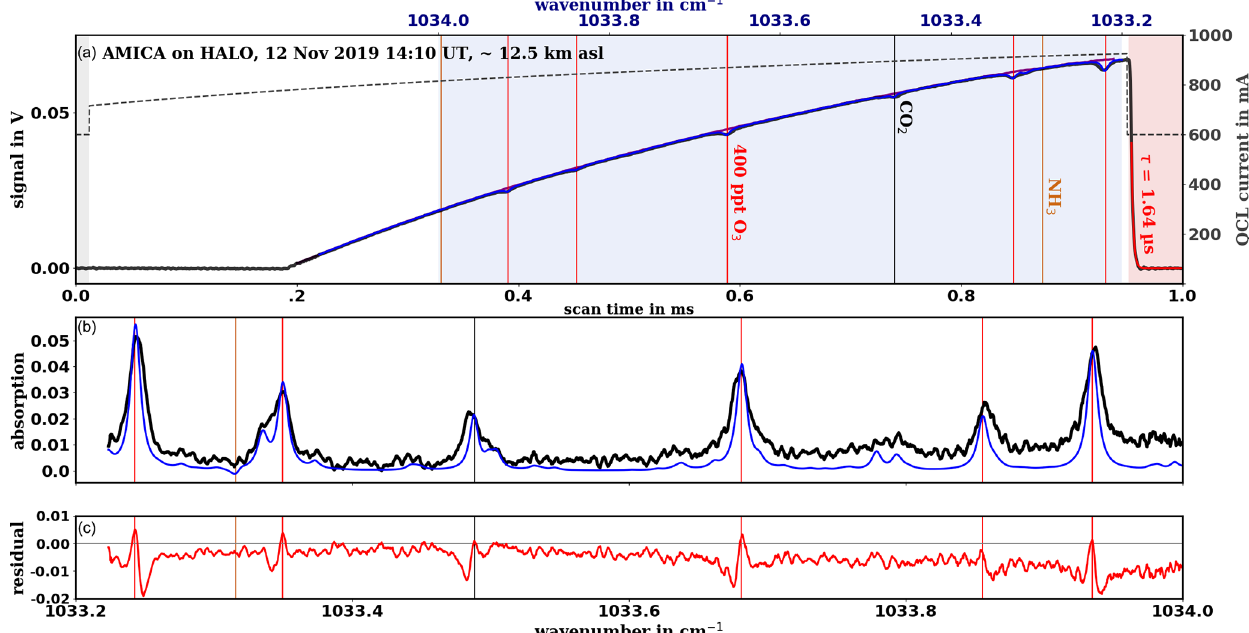
Figure 10. (a) QCL current (dashed line, right axis; the 775–925mA ramp is slightly curved to arrive at the linear wavenumber scale indicated on the top x axis) and detector voltage signal past the preamplifier (solid black line, left axis; ramps averaged over 30s) for AMICA cavity 2 in the 1034cm − 1 setup. Three periods are marked by the coloured areas – (i) grey: only detector dark signal (with zero offset) is observed; (ii) blue: period used for spectral analysis; (iii) red: period after the QCL stops emitting, when the signal decays exponentially due to ring down of the light in the cavity. A ring-down fit is shown by the red line. For the spectral fitting region, a measured baseline spectrum with no absorbers present (purple) and a fitted spectrum (blue) are also shown. (b) Measured and fitted spectra from (a) shown in absorption space. (c) Difference between the fit and the measured spectrum (fitted–measured). Panels (b, c) only show data for the region that is actually fitted, i.e. the blue shaded region in (a) . Absorption line positions coloured according to different gases are indicated in all panels by vertical lines for better comparison.